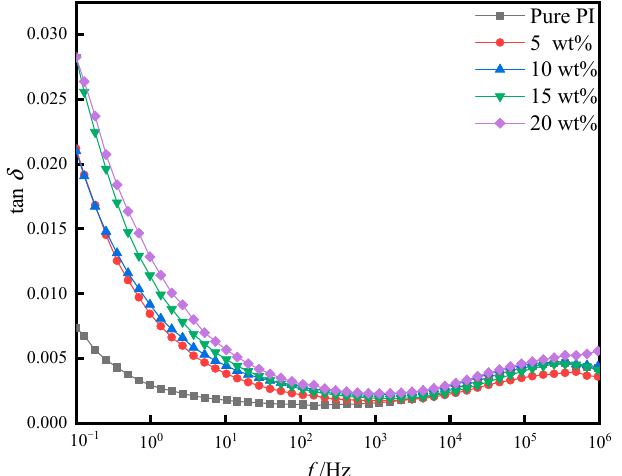
Figure 10. Dielectric loss of pure PI film and different doping amounts of PI/SiO 2 composite films with frequency.